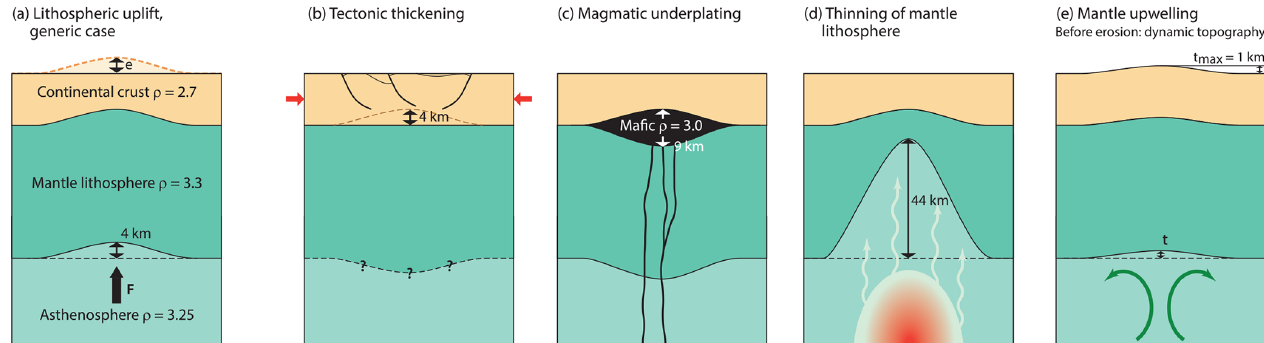
Figure 12. Scenarios for domal uplift inducing 4km of erosion as discussed in the text. All indicated density values are in grams per cubic centimetre (gcm − 3 ). Sketches are not to scale. (a) Generic case of lithospheric uplift with 4km of crust eroded and 4km of asthenosphere added; the thickness of the lithospheric mantle is unchanged. (b) Crust thickened by folding and thrusting restored to original thickness by erosion. Tectonic thickening of lithospheric mantle depends on its original thickness and was not considered in our estimate. (c) Underplating by mafic melt. The mafic lens lifts up the Moho but does not replace continental crust. The thickness of the lithospheric mantle unchanged. (d) Thinning of the mantle lithosphere by thermal erosion. (e) Dynamic topography caused by mantle upwelling. After erosion, the config- uration is similar to (a) , with asthenosphere replacing continental crust. In nature, (c) , (d) and (e) are not mutually independent. See Table 1 for a derivation of numerical values. Table 1. Estimates of parameters for the mechanisms of uplift and exhumation discussed in the text.